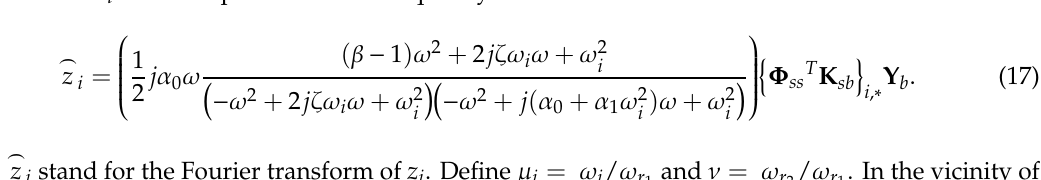
(cid:17) (cid:16) ζ r = 2 ζ i